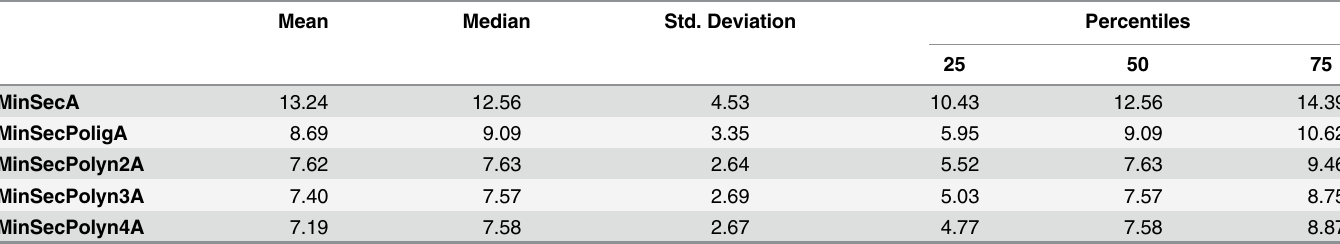
Table 4. Descriptive data for minimum NLC sectional area.